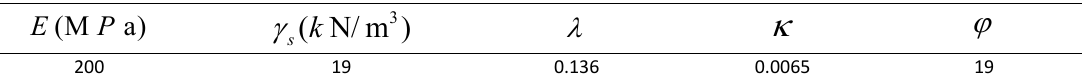
Table 3: Mechanical properties of MSW